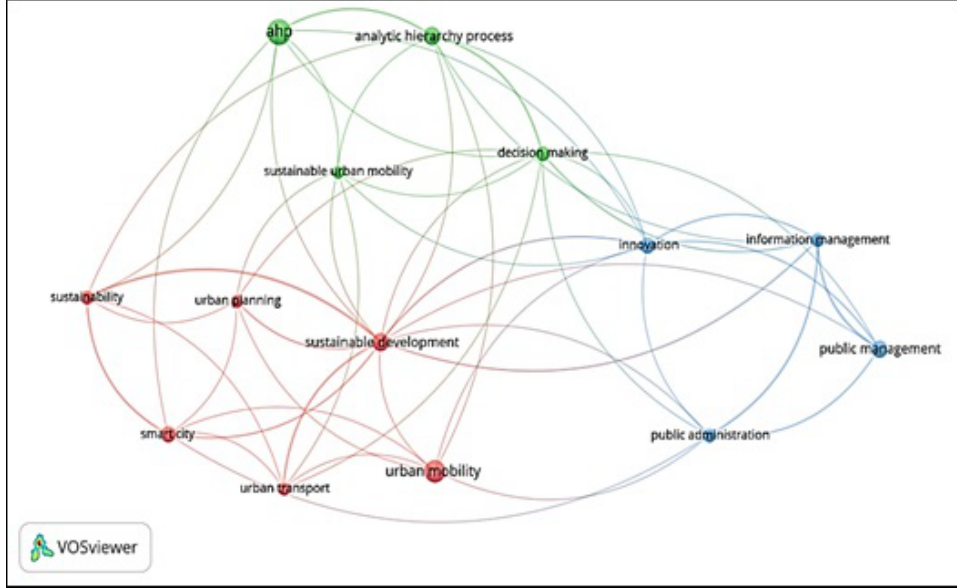
Figure 4. Keywords network (Source: www.vosviewer.com, accessed from January to June